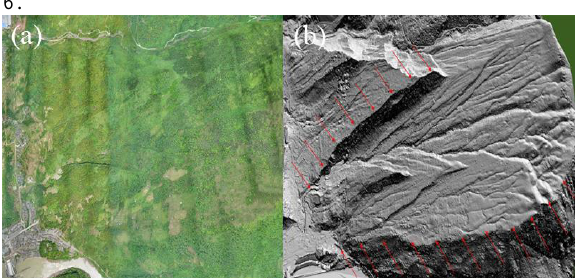
Figure 6. (a) is an optical remote sensing image, (b) is a debris flow disaster found after removing vegetation from airborne LiDAR data